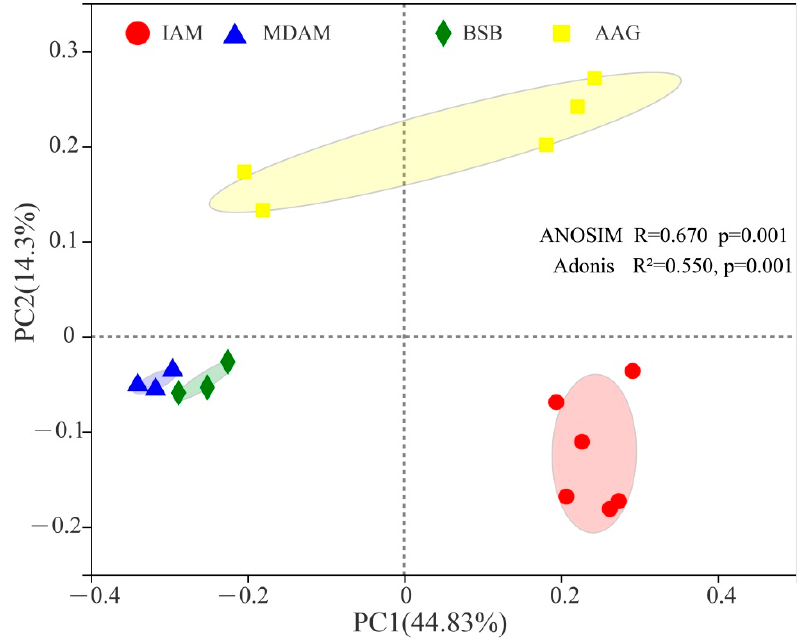
Figure 2. Principal coordinates analysis (PCoA) of bacterial communities in the alpine meadows with different groups based on the Bray–Curtis distances. IAM, intact alpine meadow; MDAM, moderately degraded alpine meadow; BSB, black soil beach; AAG, artificial grassland.